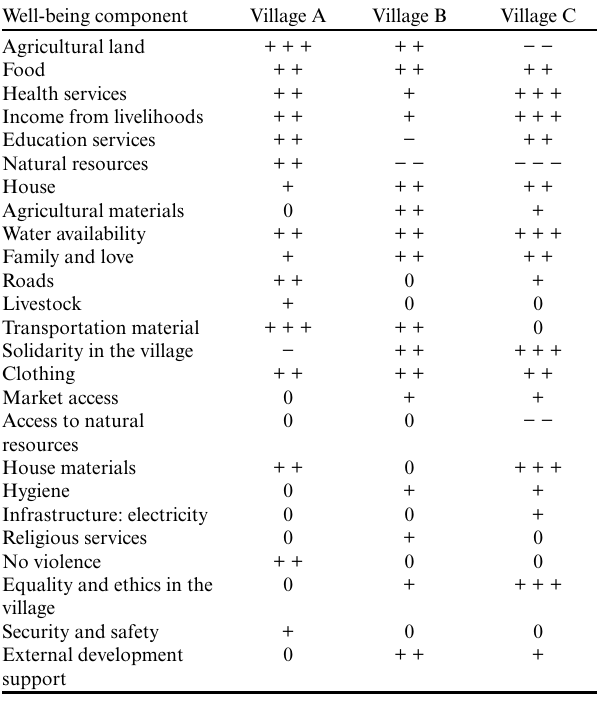
Table 7. Perceived changes in well-being component satisfaction from focus groups across villages, ranked according to cultural salience. Changes rated as: highly positive, + + +;